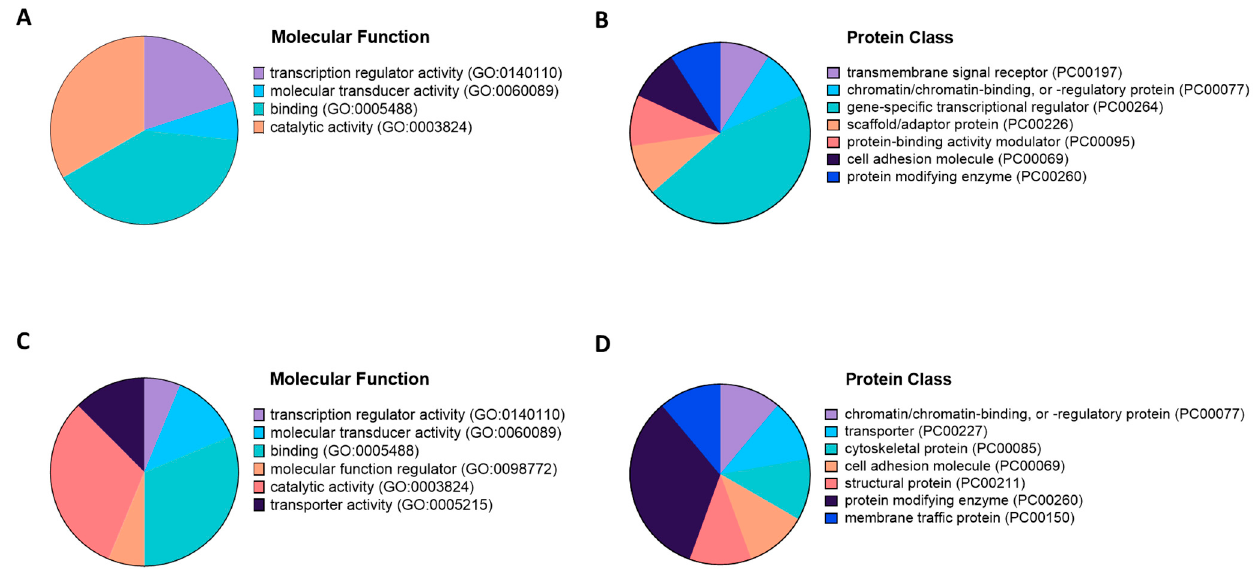
Figure 3. Categorization of gene ontology (GO) annotations of hsa-miR-21-5p and hsa-miR-21-3p with PANTHER. Graphical representation of the molecular function ( A , C ) and protein class ( B , D ) GO terms for the top twenty targets of hsa-miR-21-5p ( A , B ) and hsa-miR-21-3p ( C , D ).